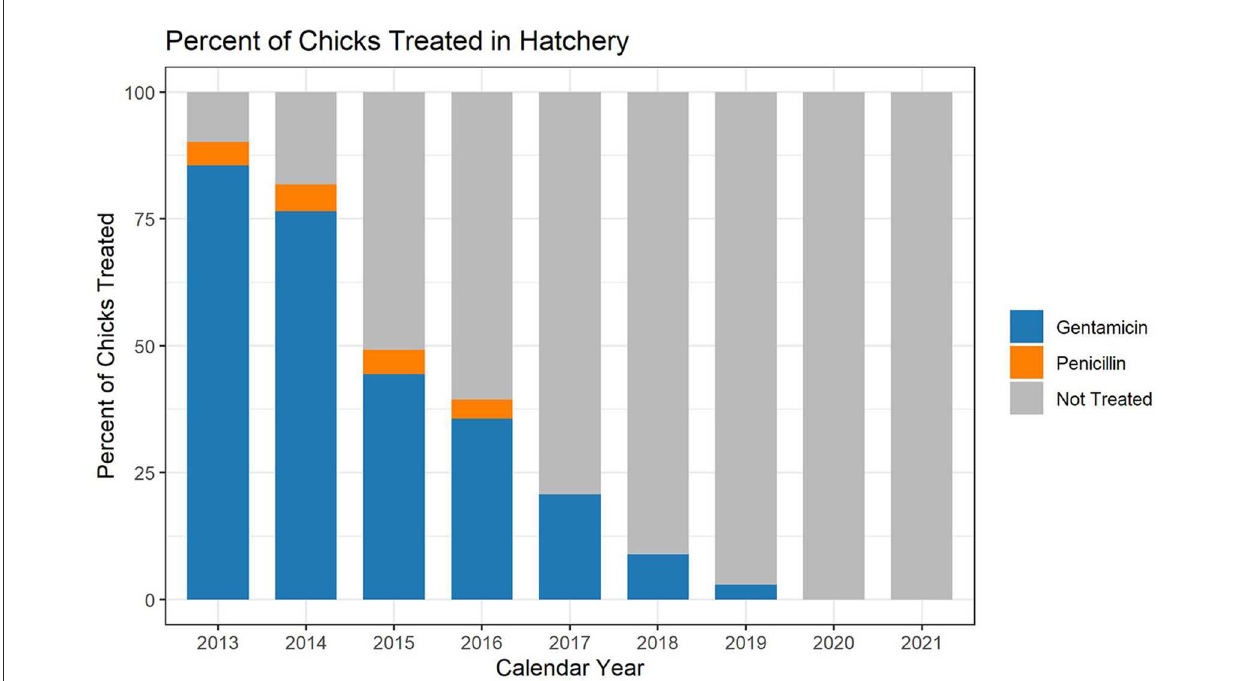
FIGURE2 Broiler hatchery antimicrobial use during the years 2013–2021, as a percentage of total birds placed. The graph shows the percentage of birds placed that received gentamicin, penicillin or no antimicrobial.